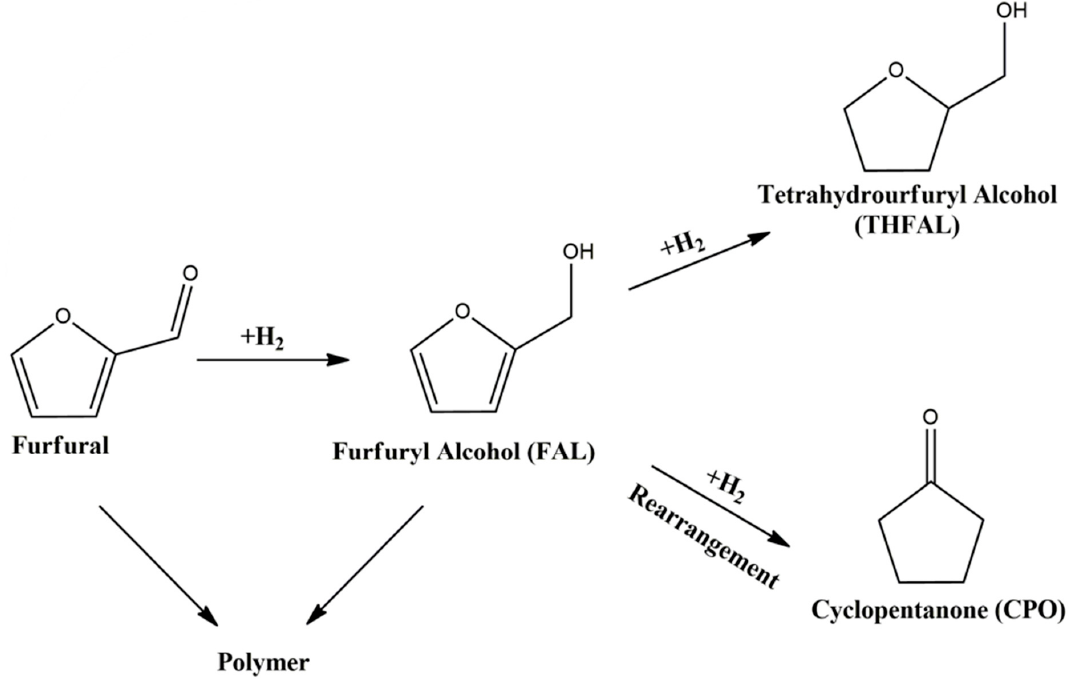
Figure 1. Reaction pathways in liquid phase hydrogenation of furfural.